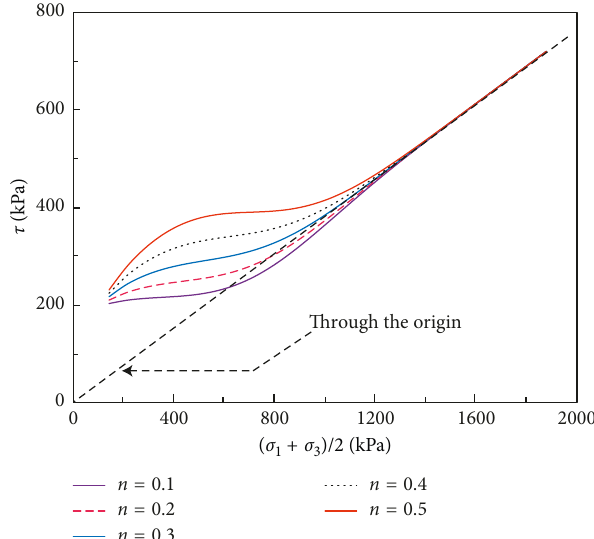
Figure 9: Influence of parameter ( n ) to evolution laws of shear